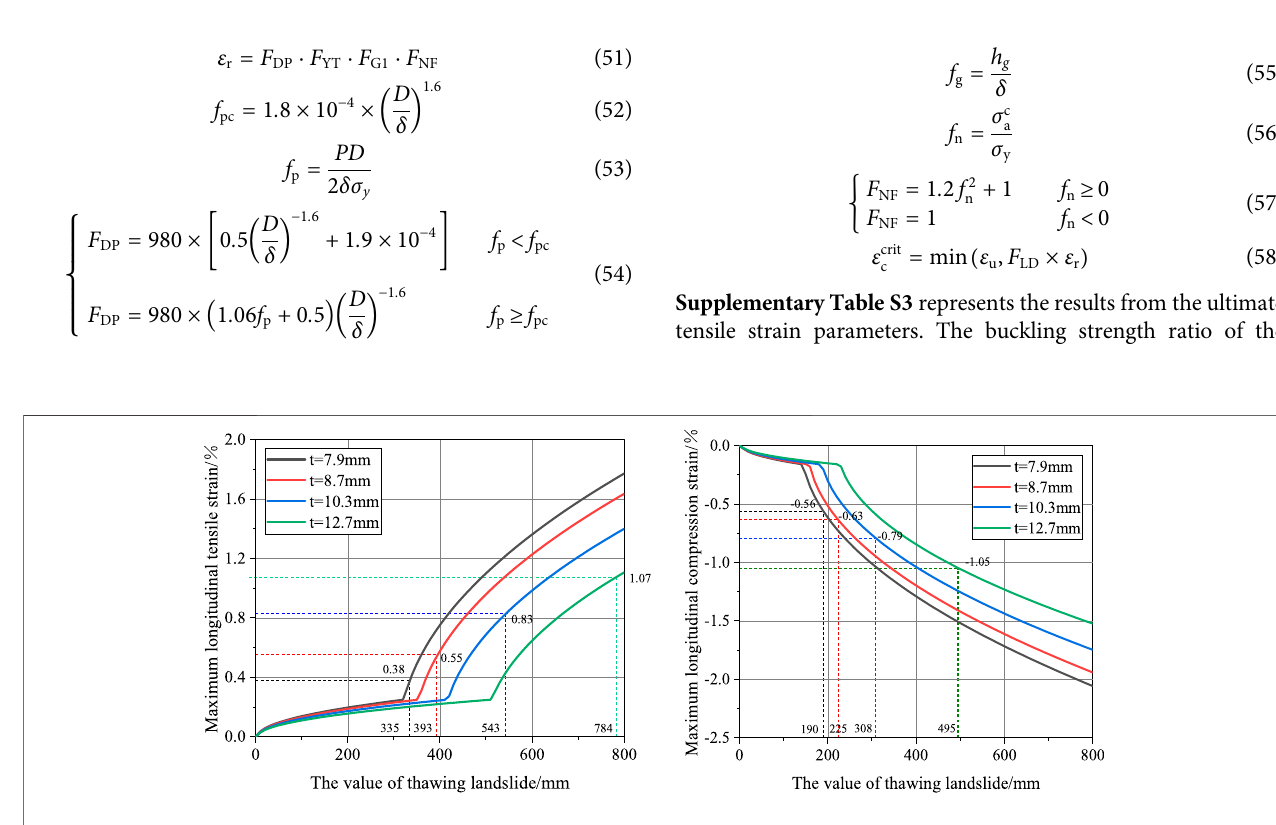
FIGURE 13 | In fl uence of wall thickness on the maximum longitudinal